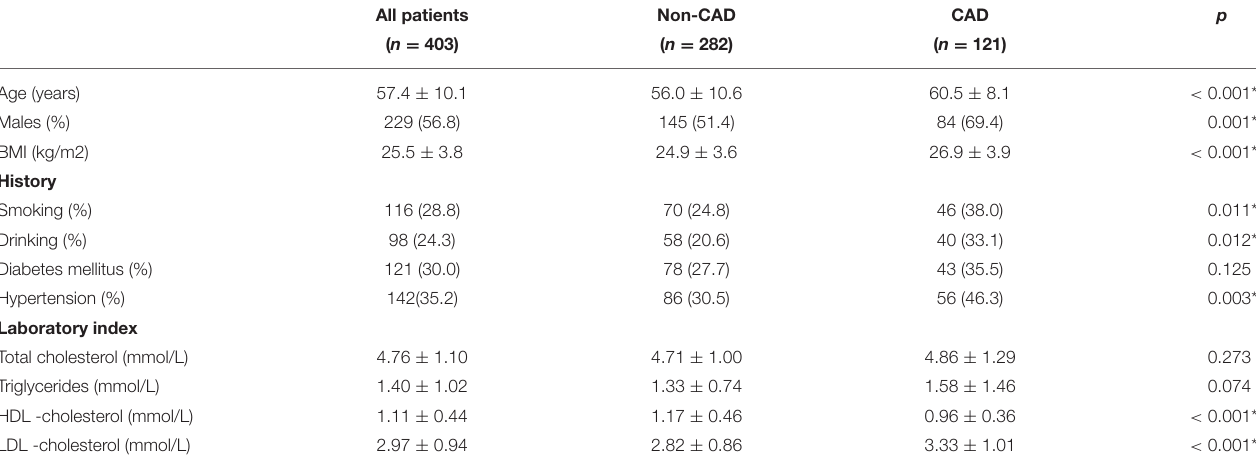
TABLE 1 | Baseline characteristics of study cohort ( n = 403). All patients Non-CAD CAD